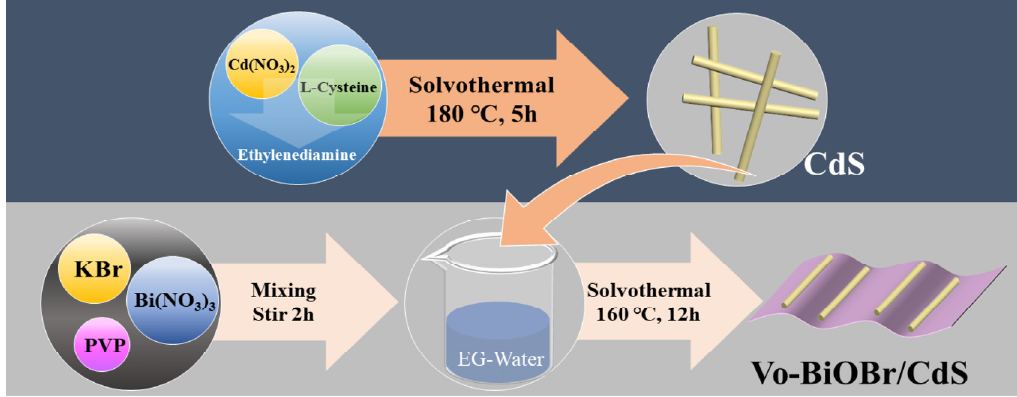
Figure 1. Diagram of the synthesis process of Vo-BiOBr/CdS photocatalysts.